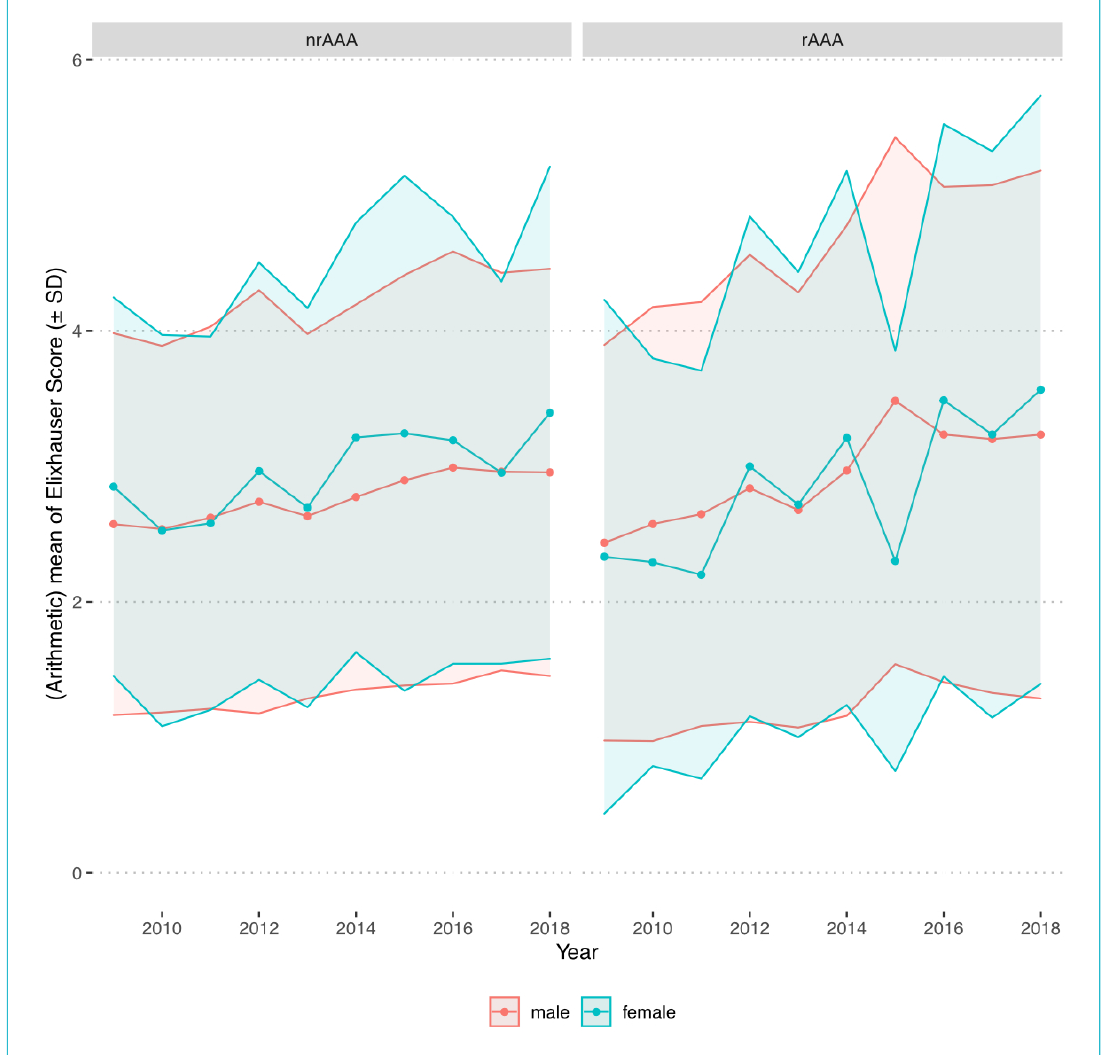
Figure S1: Comorbidities of patients treated for abdominal aortic aneurysm (AAA). Comorbidities were summarised using a sum score of weighted Elixhauser ICD-10 diagnosis groups according to van Walraven.18 The score is calculated from grouped ICD-10 diagnosis per pa- tient and weighted based on the association of each category and mortality. The figure shows the mean score per year stratified by sex and di- agnosis (nonruptured AAA [nrAAA] versus ruptured AAA [rAAA]). SD = standard